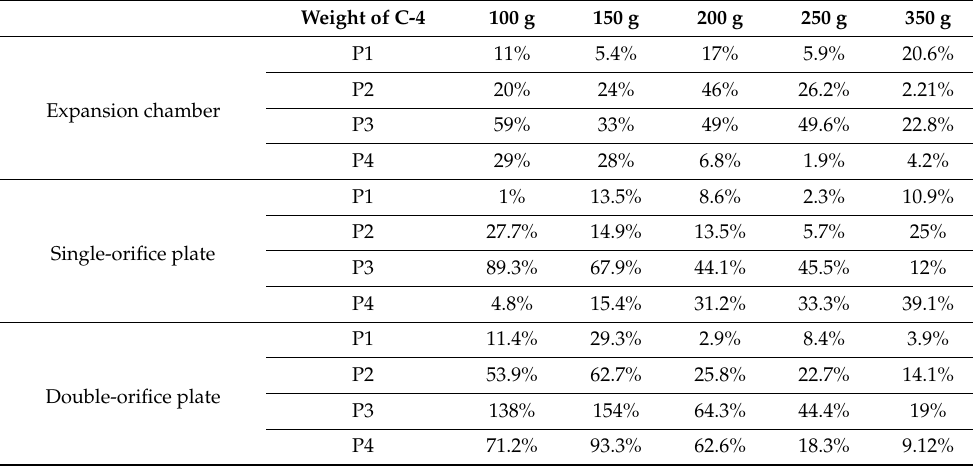
Table 4. Percentage error of different pressure attenuation